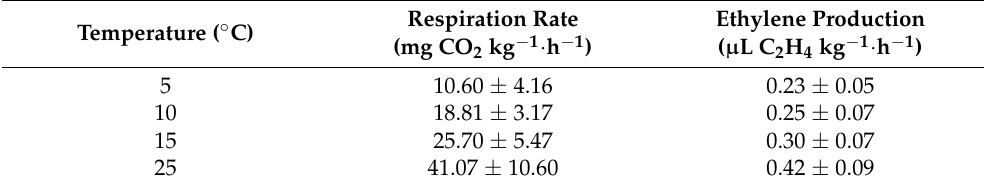
Table 1. The effects of different temperatures on the winged bean pod’s respiration rate and ethylene